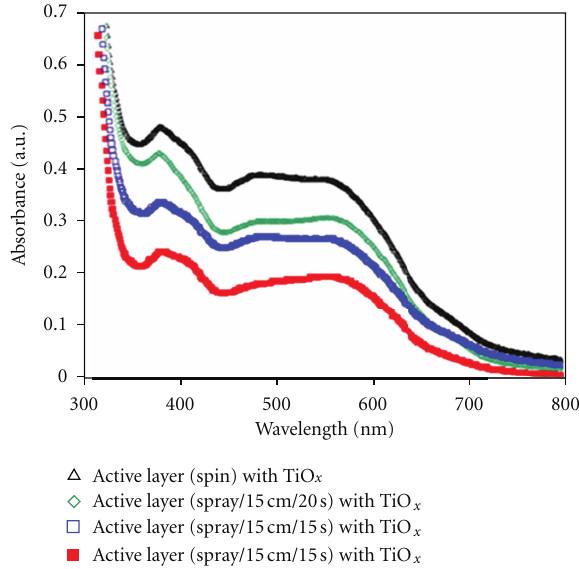
F 3: Absorption spectrum of PCDTBT:PC